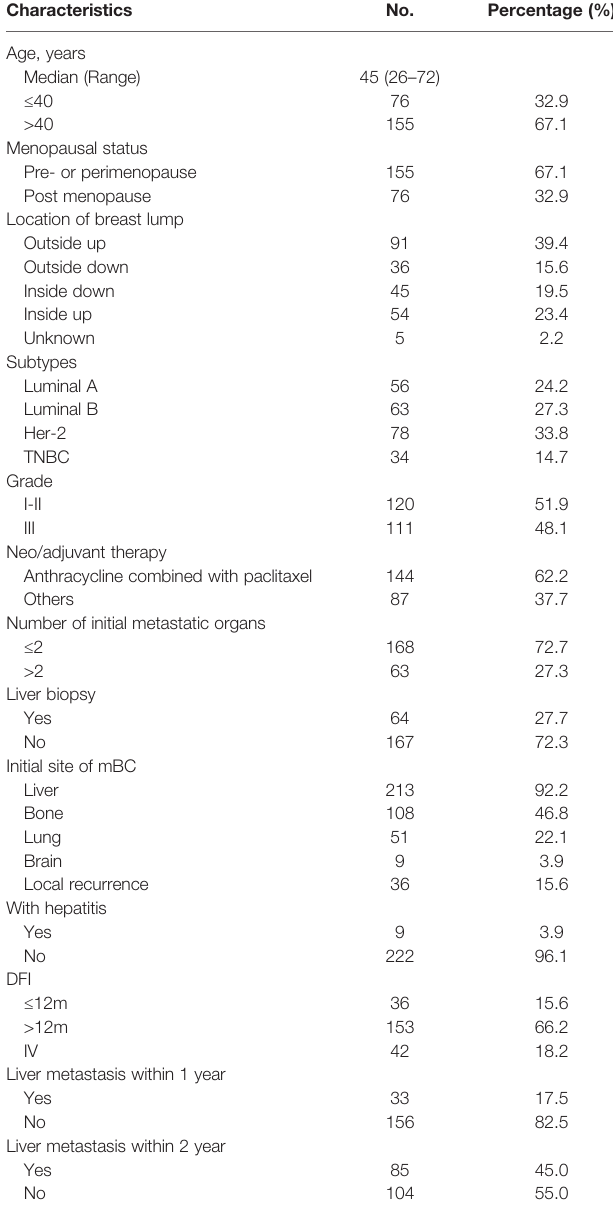
TABLE 1 | Clinicopathological characteristics of patients (N = 231). Characteristics